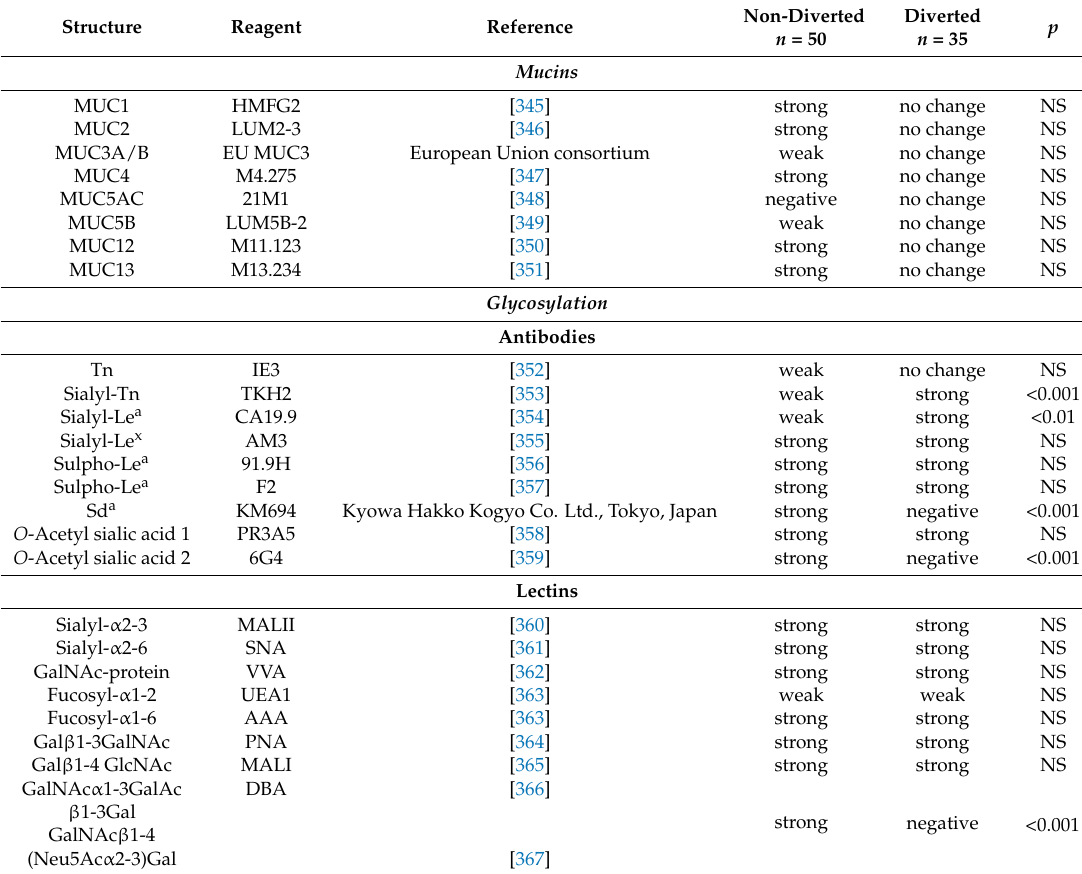
Table 7. Expression of Mucin Gene Proteins and Mucin Glycosylation in Diverted and Non-Diverted Colonic